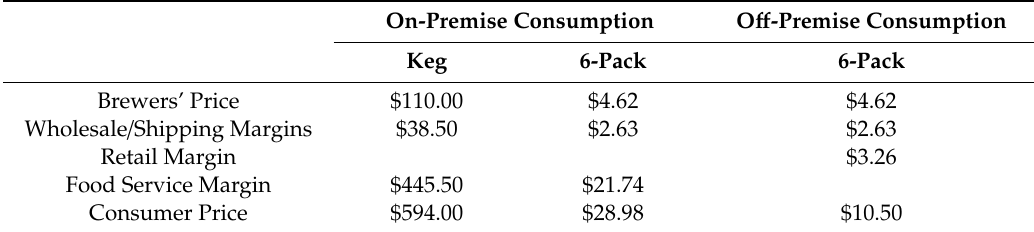
Table 1. Beer prices at points of